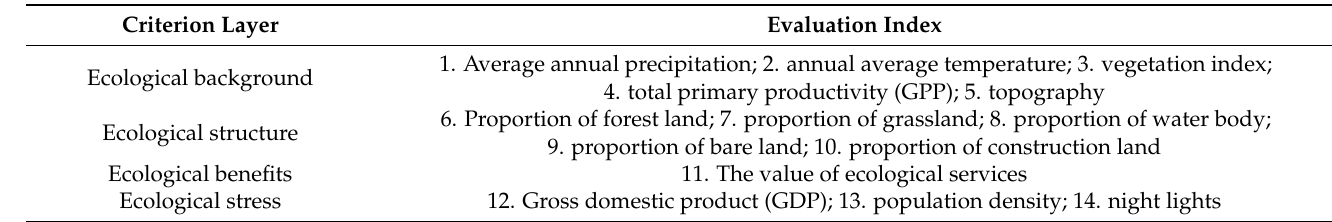
Table 2. Remote sensing evaluation index system for land ecological quality. Criterion Layer Evaluation